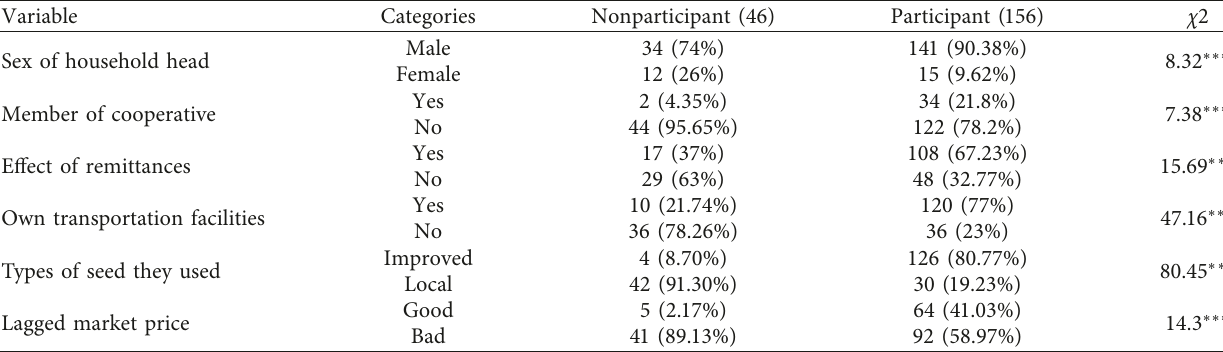
Table 2: Two-group mean comparison test of dummy variables.